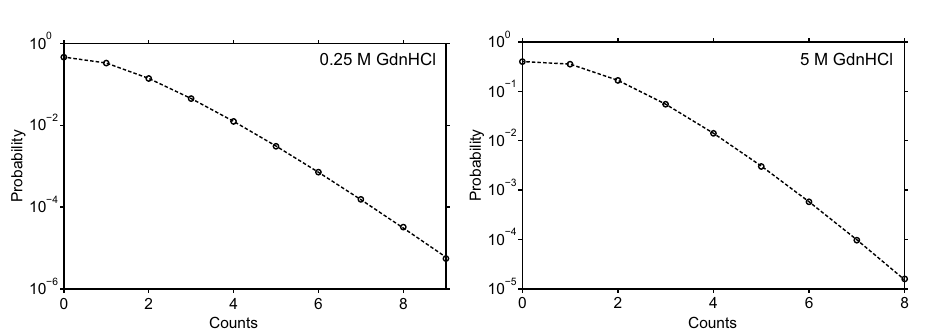
Figure 2. Photon counting histograms of AF488-C(0)A β 42 in 0.25 M GdnHCl solution (left) and in 5 M GdnHCl solution (right). 0.25 M GdnHCl was the lowest GdnHCl concentration applied in the 1fFCS measurements whose data was used to generate the photon counting histograms. Each dashed line in this figure represents a fit to a one-component model. A reduced chi-squared of χ r2 = 0.6 and 1.2, respectively, indicates an excellent fit to this model where the F-value (equation (S16)) was determined from a separate measurement with free AF488 dye.